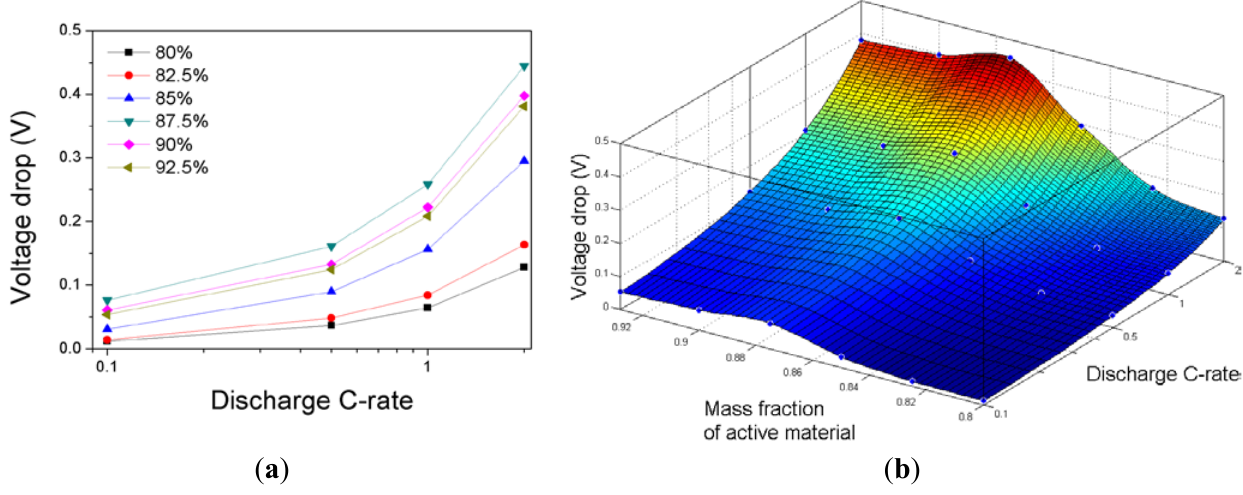
Figure 7. ( a ) Voltage drops due to an increase in DOD from 0.2 to 0.8 with discharge rates ranging from 0.1C to 2.0C for various compositions of the cathode; and ( b ) three-dimensional surface plot of the voltage drop due to an increase in DOD from 0.2 to 0.8 as a function of the discharge C-rate and the mass fraction of active material in the